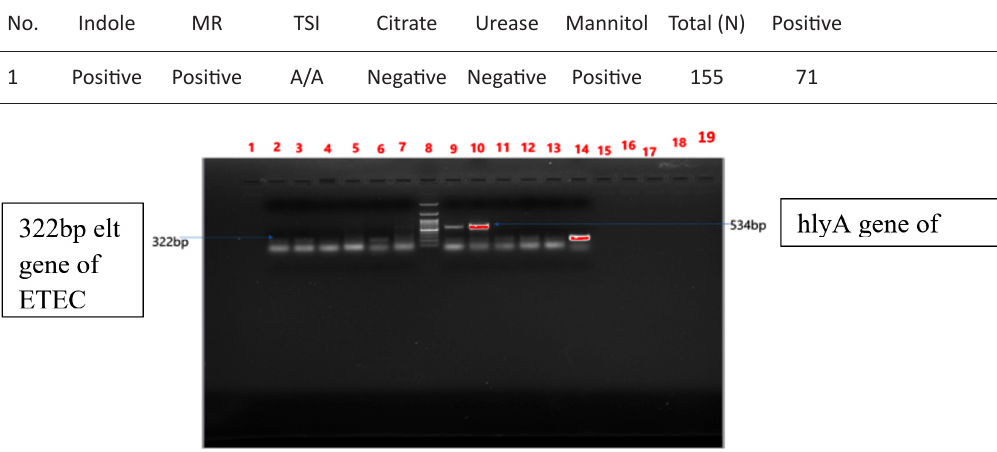
Fig. 1. Multiplex PCR of pediatric samples. Lane 2-7 and 11-14 ETEC ( amplicon size 322bp) and Lane 9-10 EHEC